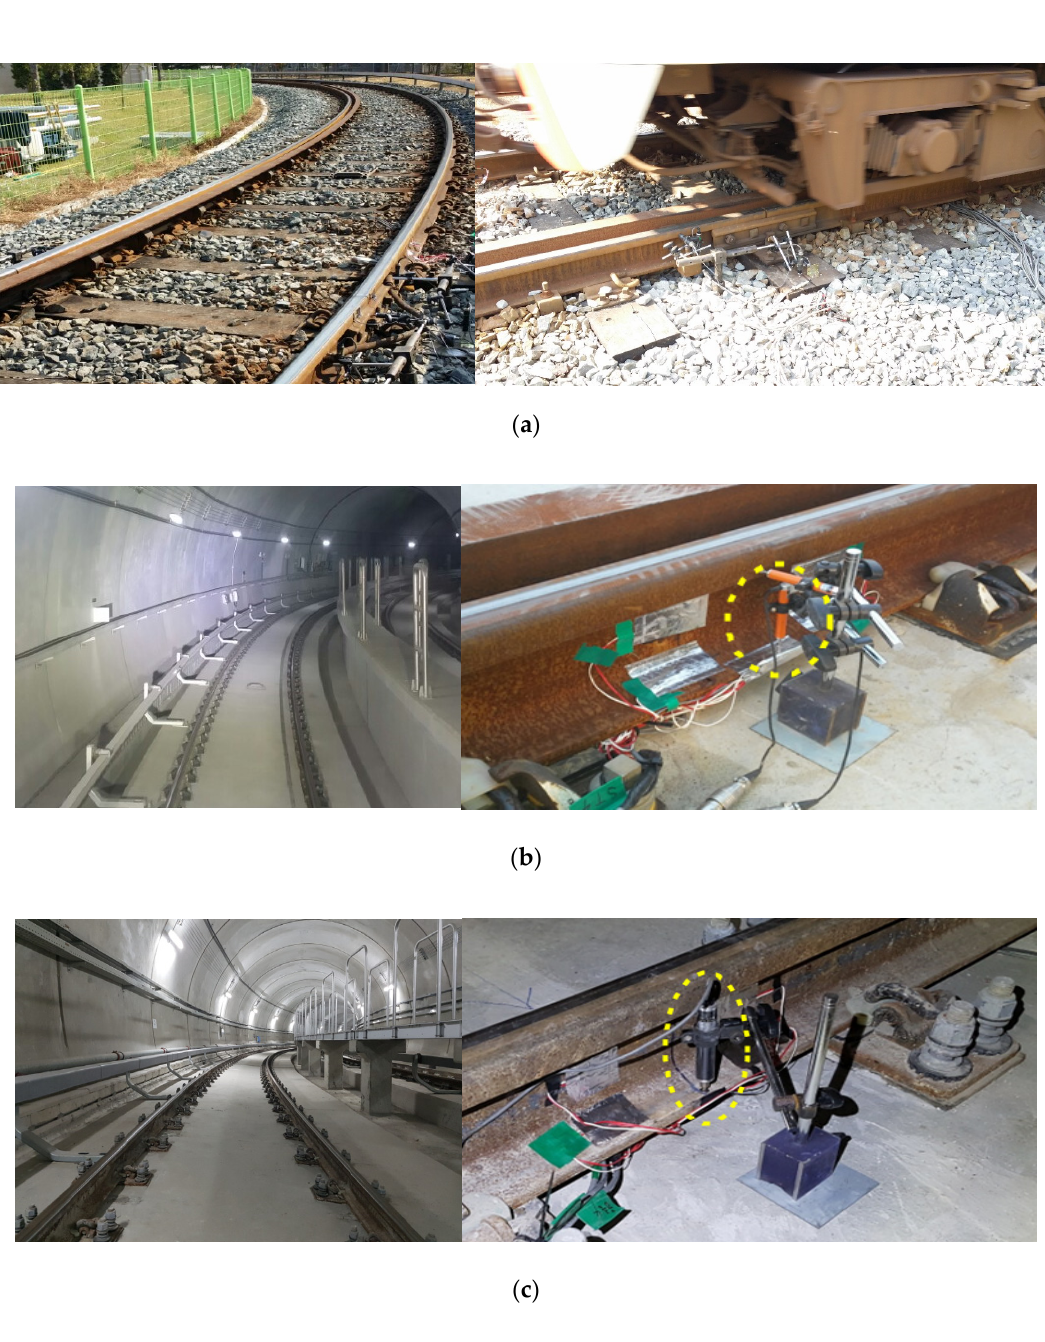
Figure 3. Test sections and instrumented sensors. ( a ) Section A; ( b ) section B; and ( c ) section C. Table 1. Properties of the test